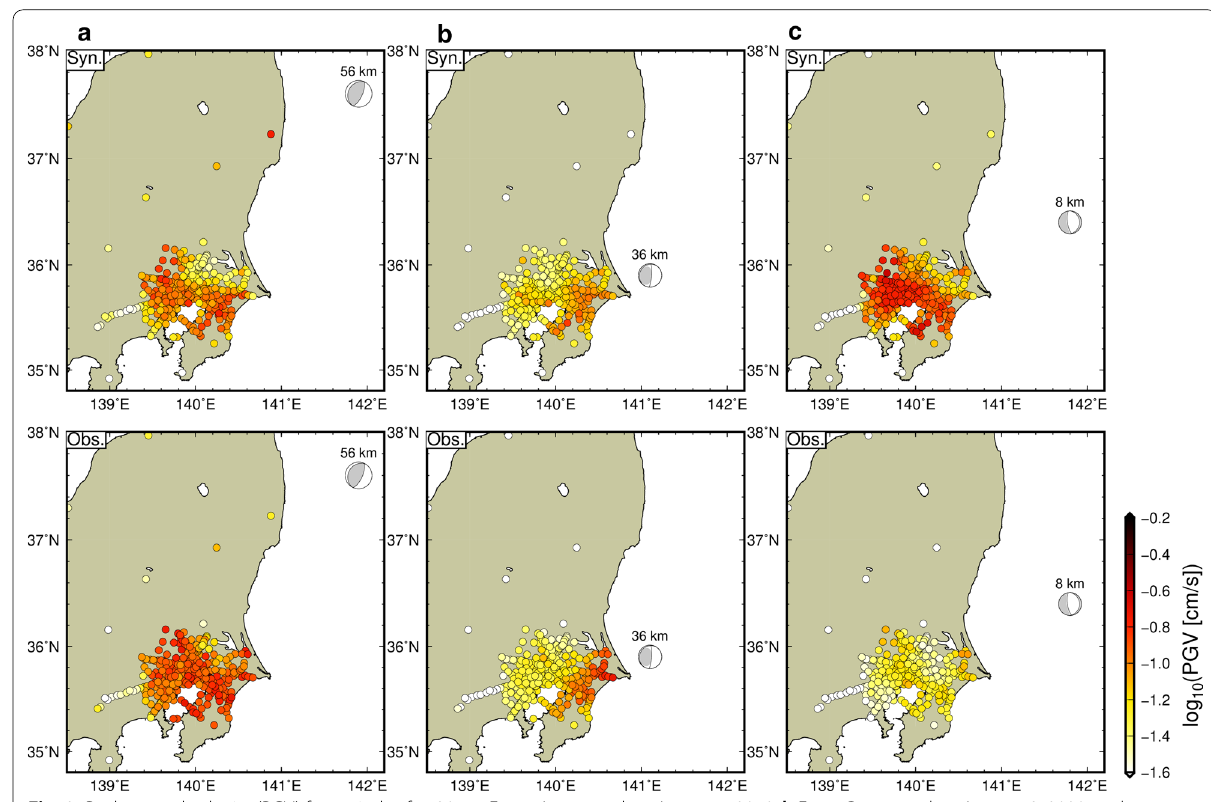
Fig. 9 Peak ground velocity (PGV) for periods of 5–30 s. a Event A occurred on August 4, 2019, b Event B occurred on January 3, 2020, and c Event C occurred on February 6, 2020. Detail source parameters described in Events a–c of Table 3. The top and bottom panels are the synthetic and observed PGVs, respectively. PGVs were evaluated by calculating the vector sum of three-component filtered seismograms at the F-net and MeSO-net stations. Plotted focal mechanisms are the optimal solutions of the 3D CMT inversions for the corresponding events. The JIVSM bedrock depths are illustrated in Figs. 1, 7 and 9, 10 and